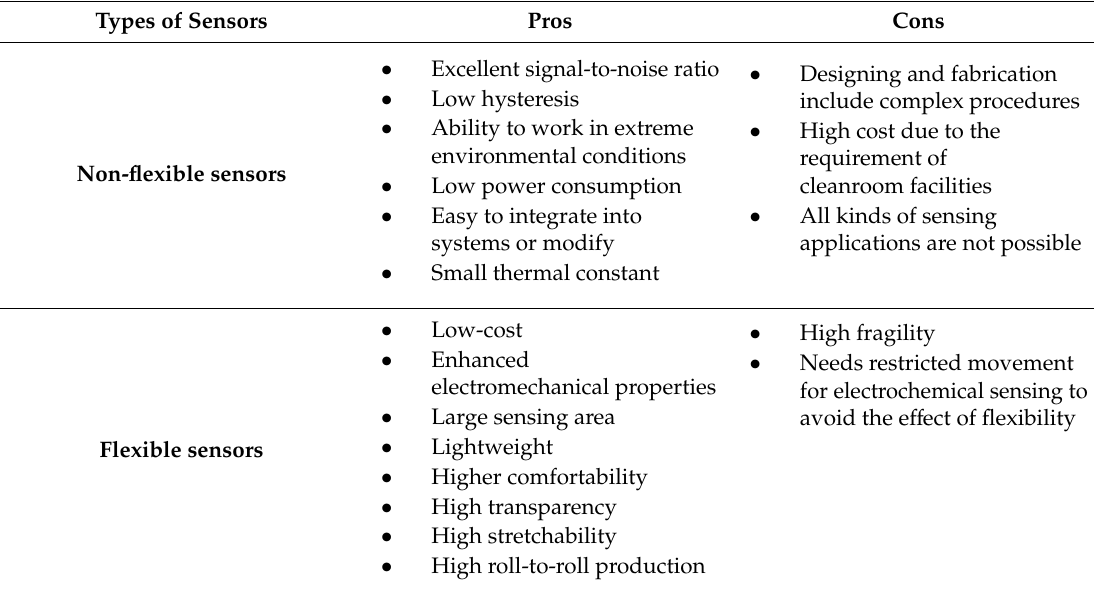
Table 1. Comparative study of the pros and cons of flexible and non-flexible